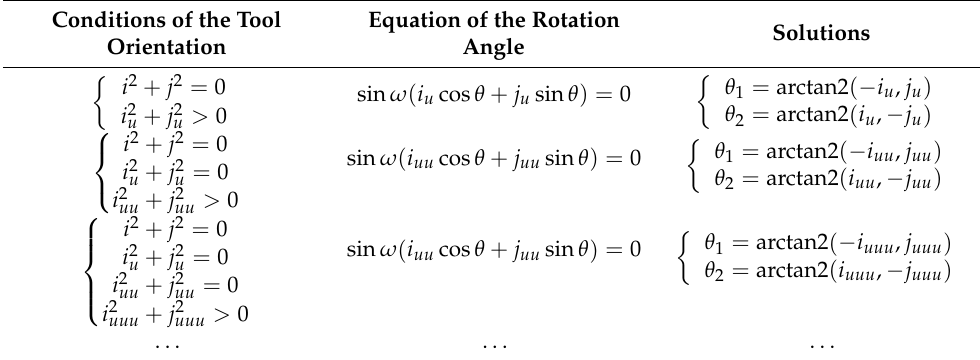
Table 1. Rotation-angle handling at the singularity point based on the derivatives of the tool orienta- tion